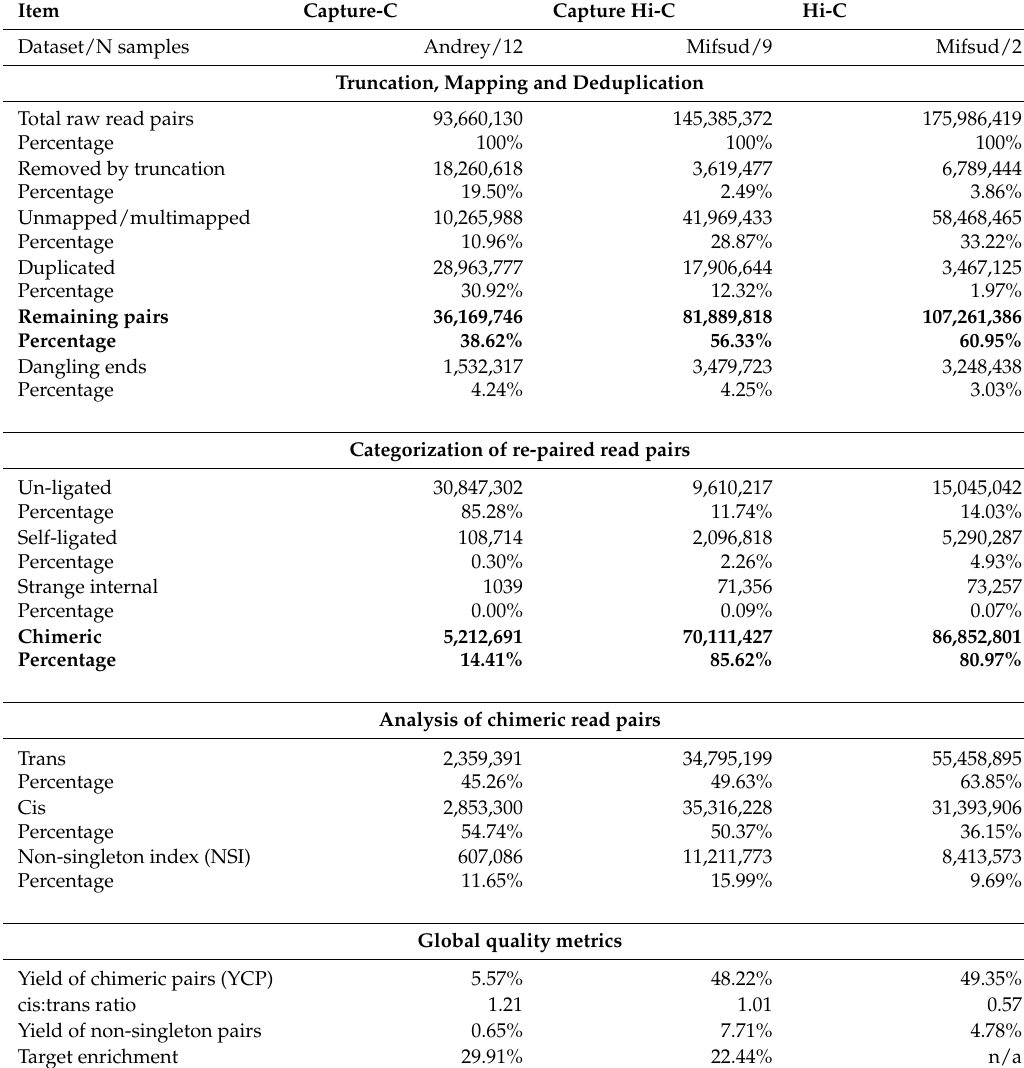
Table 2. Average read pair counts and quality metrics for Capture-C, CHC and Hi-C datasets. The percentages for truncation, mapping and deduplication were calculated with respect to the total number of read pairs. The percentages for read pair categorization were calculated with respect to the number of reads that could be re-paired (remaining reads from the first processing steps). Percentages of cis and trans read pairs as well as read pairs in non-singleton interactions were calculated with respect to the total number of pairs that were categorized as chimeric. See Table 1 for explanation of the quality